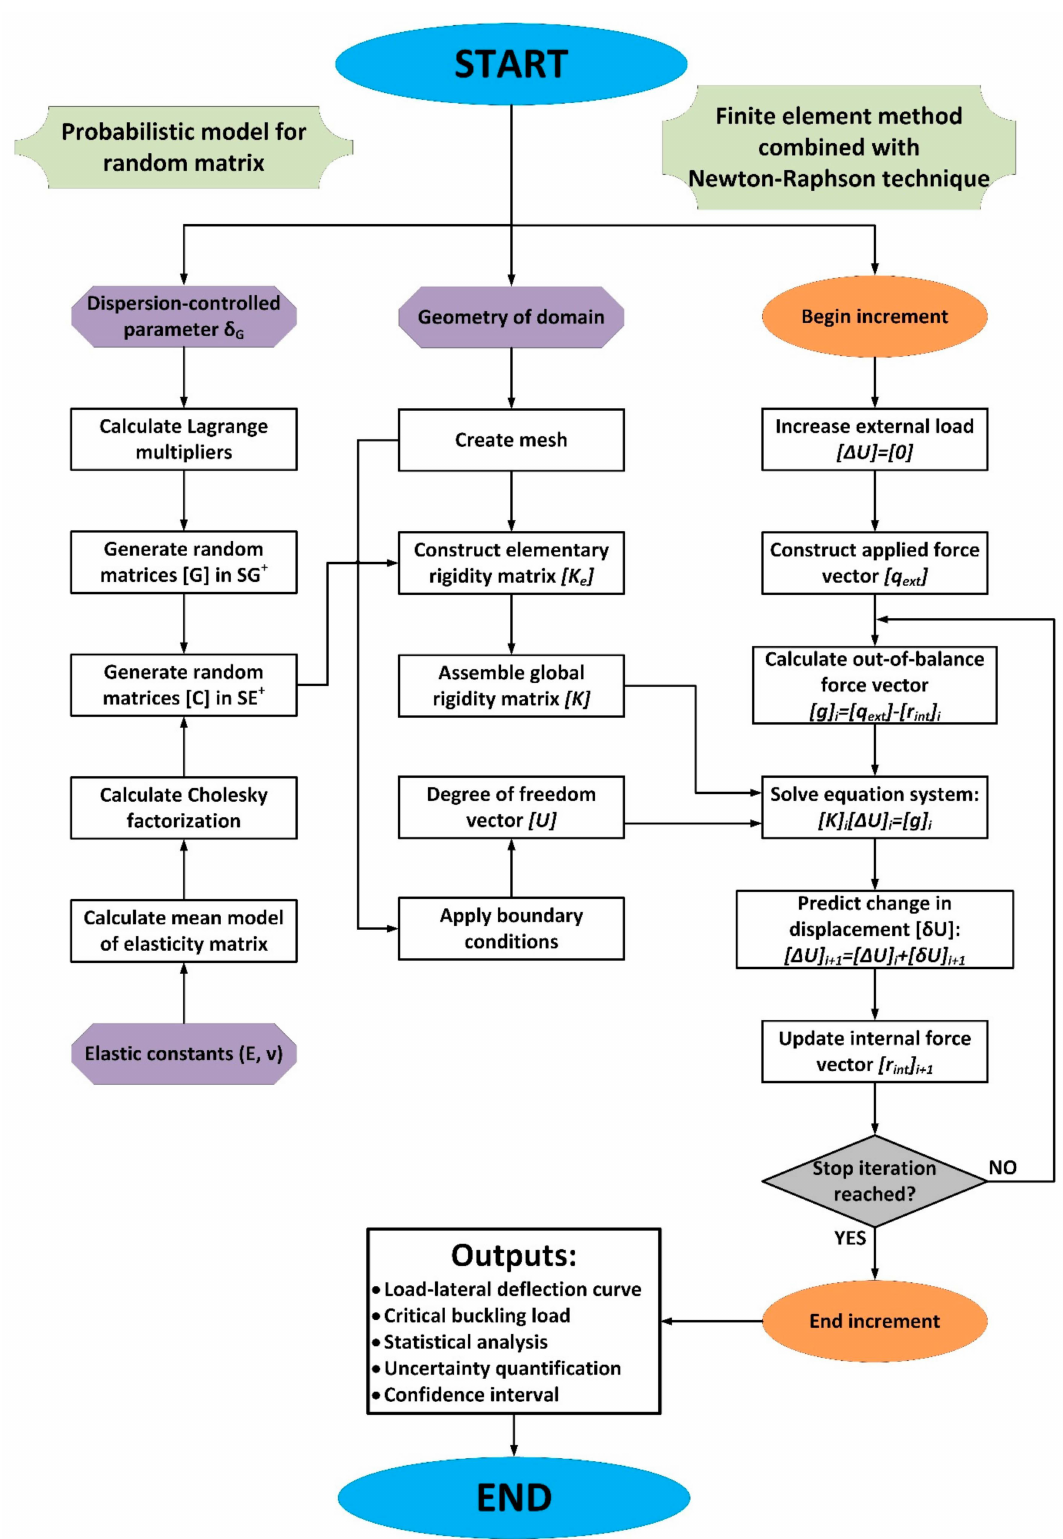
Figure 2. Methodology modeling of the present study including probabilistic model for random matrix and finite element tool combined with the Newton-Raphson